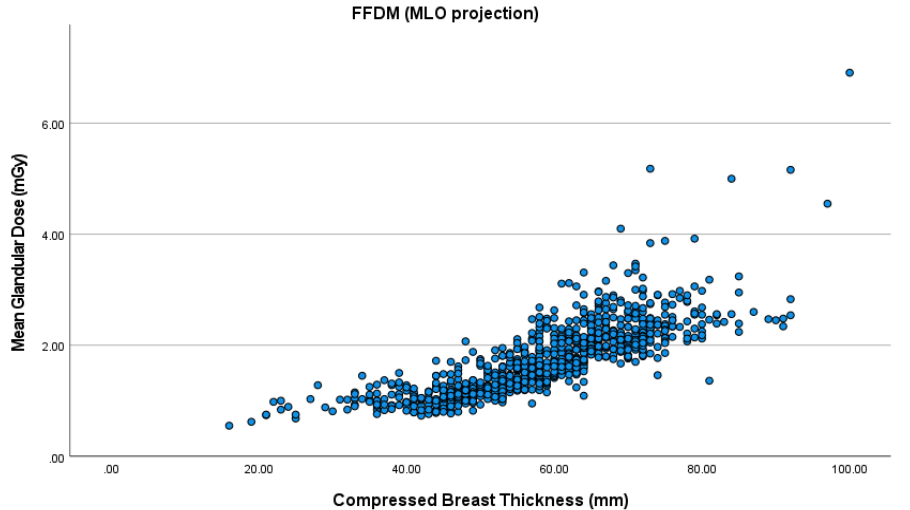
Figure 1. Mean glandular dose (MGD) in full ‐ field digital mammography (FFDM) in the cranio ‐ caudal (CC) projection.